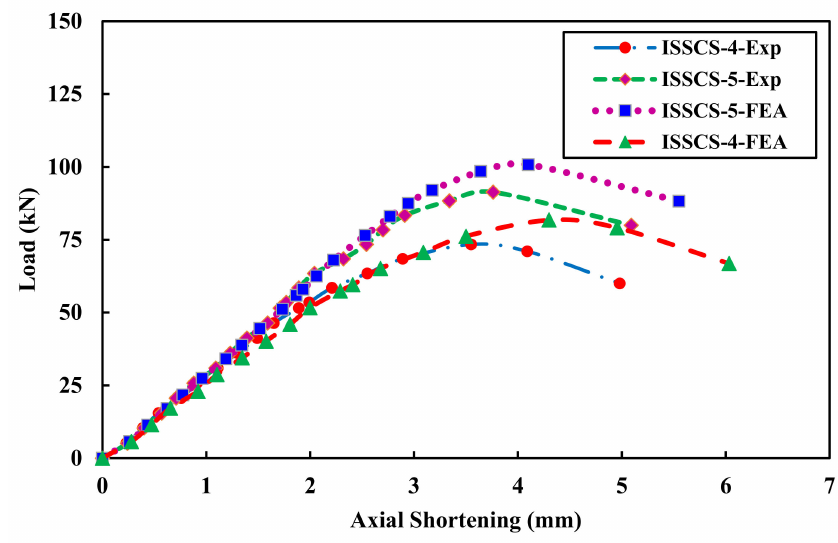
Figure 15. Typical load versus axial shortening curves from the results of experiments and FEA.